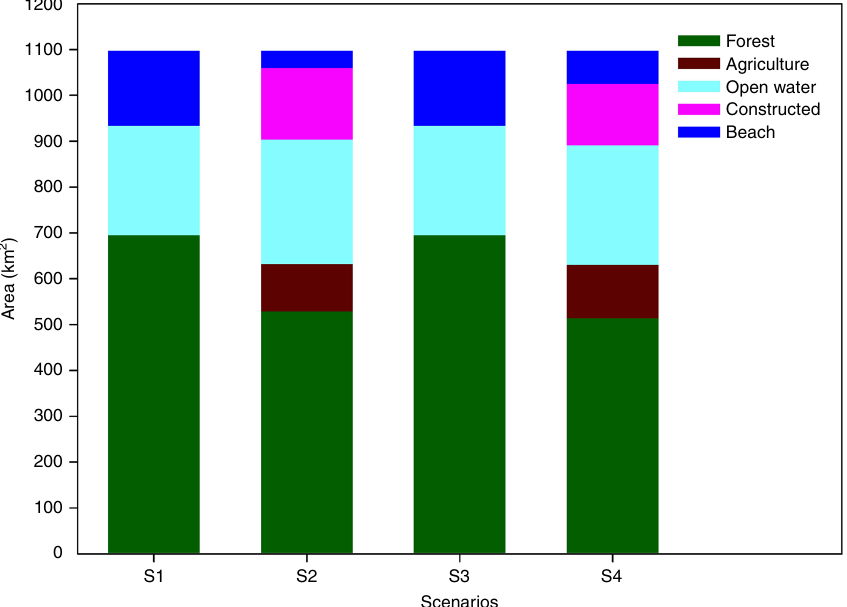
Fig. 5 Ecosystem composition of ERAs under four alternative scenarios. Shown in different colors are the total estimated land areas (km 2 ) of each major land cover and land use type in the ecological redline areas (ERAs). The ERAs in scenario 1 and scenario 3 are mainly composed of forest, open water, and beach. Without the ERP constraint, we estimate the ecosystem composition of the ERAs change, shown in scenarios 2 and 4 where forest area and beach are reduced due to land use conversion to agriculture and constructed